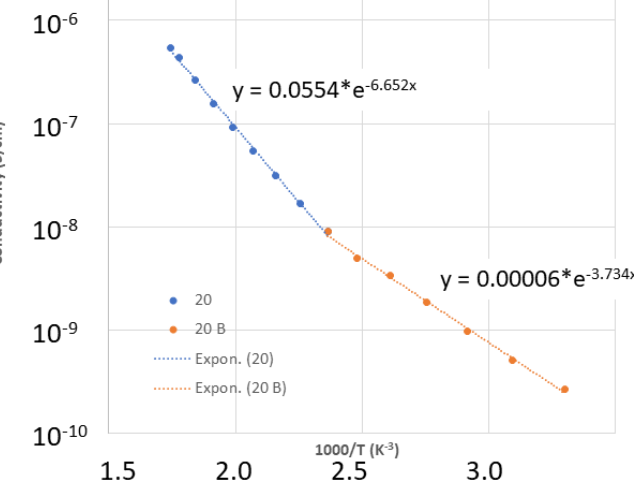
Figure 18. AC conductivity on temperature for the sample GBM 370 at frequency 20 Hz.